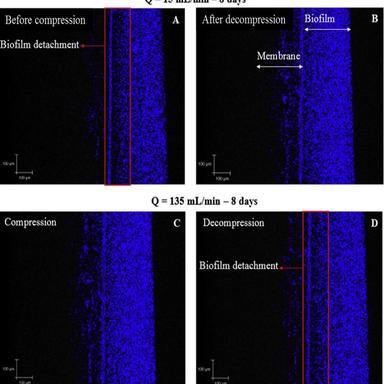
AVIZO orthoslices extracting from 2- D OCT imaging of biofilm/membrane at a feed flow rate of 15 mL/min (A and B) and 135 mL/min (C and D) achieved at day 8 of biofilm development under compression and decompression processes. The biofilm detachment area was shown inside red rectangles in and D. (For interpretation of the references to color in this figure legend, the reader is referred to the Web version of this article.)